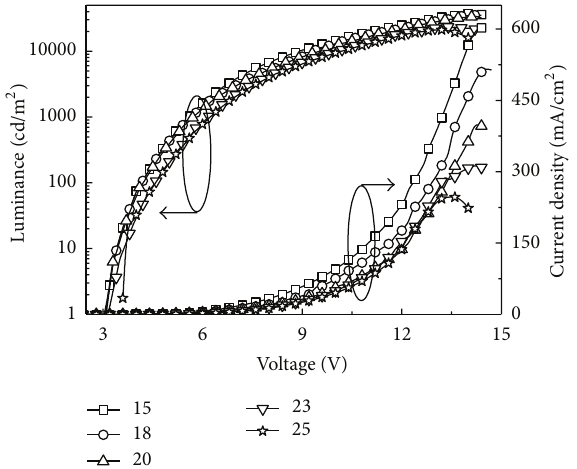
Figure 4: Luminance-bias voltage-current density characteristics of devices B1, B2, B3, B4, and B5.